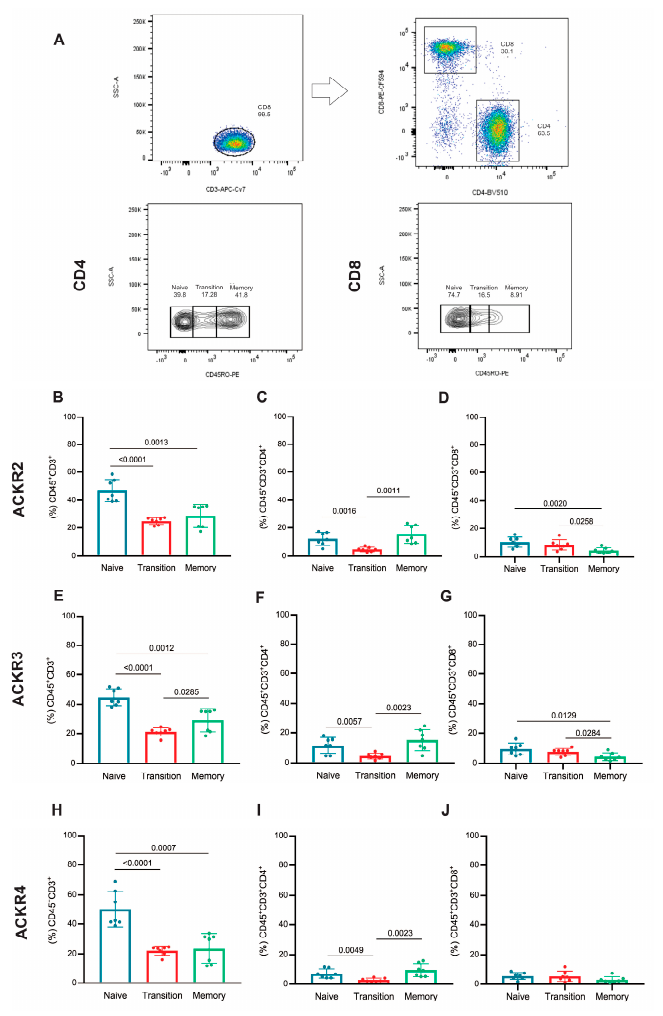
Figure 3. Frequency of naive, transition and memory T lymphocytes expressing ACKRs: ( A ) flow cytometry strategy for selection of T lymphocytes was based on their CD45 and CD3 expression, and the T lymphocytes subsets were defined by the expression of CD4 or CD8, and by expression of CD45RO these lymphocytes subsets were classified as memory (CD45RO+), naive (CD45RO − ) and transition (CD45ROint). ACKR2 ( B ) frequency in CD3 T lymphocytes, ( C ) frequency in CD3:CD4 T lymphocytes and ( D ) frequency in CD3:CD8 T lymphocyte subsets, ACKR3 ( E ) frequency in CD3 T lymphocytes, ( F ) frequency in CD3:CD4 T lymphocytes and ( G ) frequency in CD3:CD8 T lymphocyte subsets and ACKR4 ( H ) frequency in CD3 T lymphocytes, ( I ) frequency in CD3:CD4 T lymphocytes and ( J ) frequency in CD3:CD8 T lymphocyte subsets. T lymphocytes naive (blue), transition (red) and memory (green) (n =